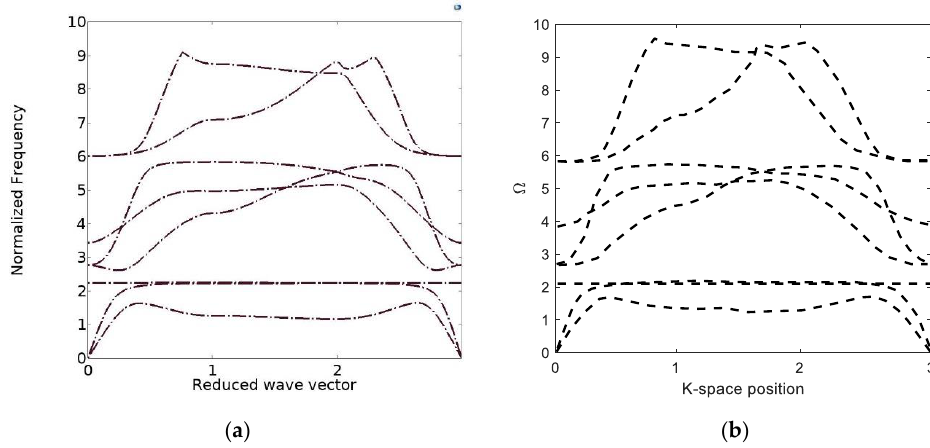
Figure 10. Verification of the band structure of the triangular topology: ( a ) the current study; ( b ) Ref. [25].